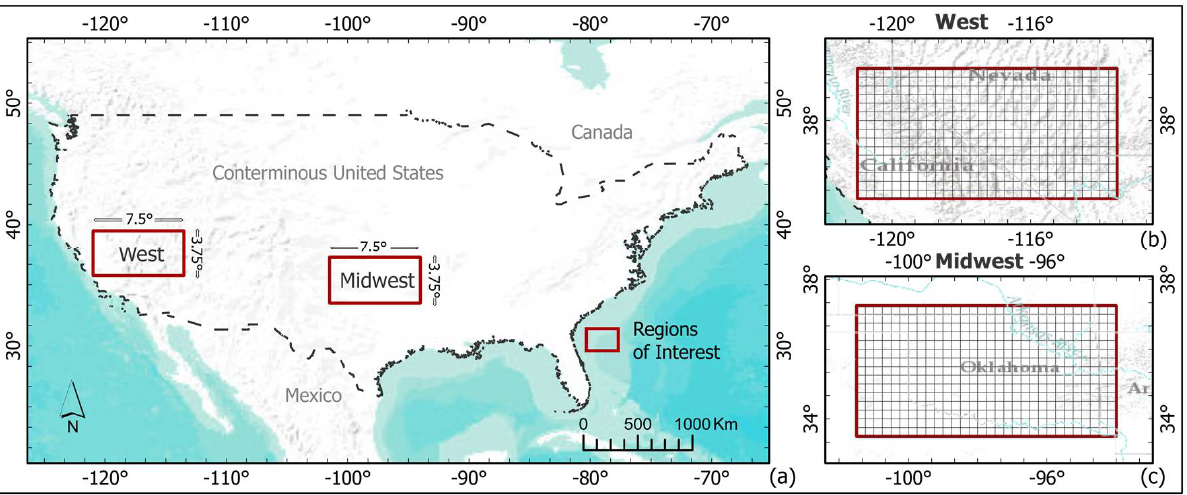
Figure 1. ( a ) Regions of interest (ROIs) for soil moisture downscaling; ( b ) West ROI; ( c ) Midwest